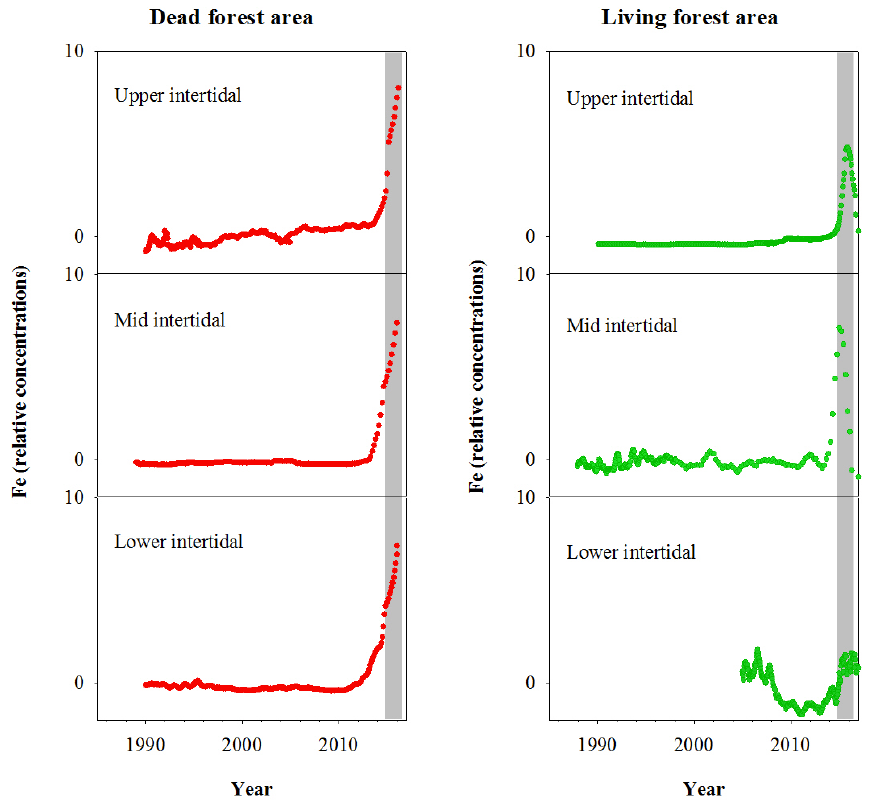
Figure 3. Fe relative concentrations in mangrove wood over time in living (green dots) and dead (red dots) mangroves from upper, mid and lower intertidal areas in the Gulf of Carpentaria, Australia. Grey areas indicate the dieback